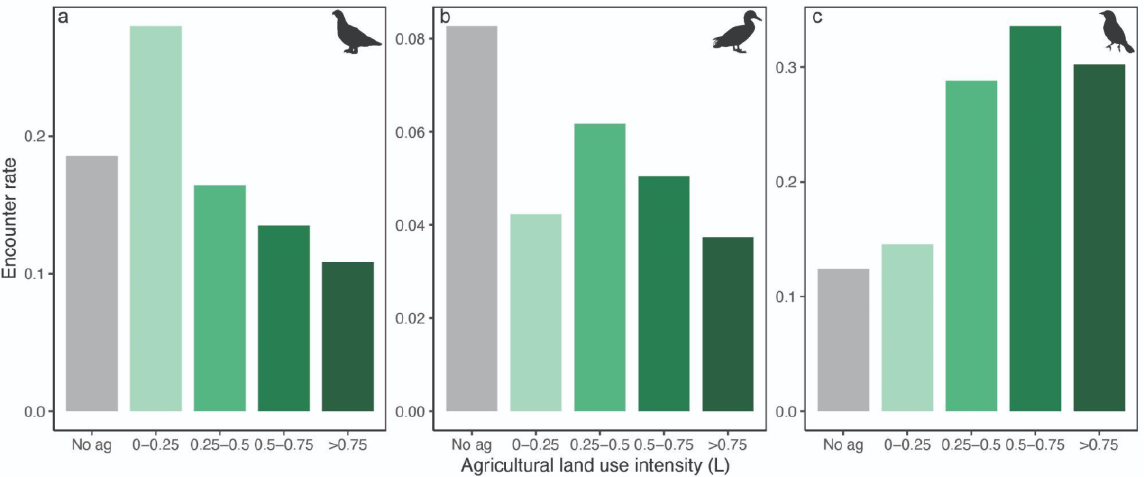
Figure 2. Median encounter rates for ( a ) Greater Sage-Grouse, ( b ) American Black Duck, and ( c ) Bobolink within bins of progressively increasing agricultural land use intensity ( L ). Median values are based on predictions from random forest models at thousands of random locations within each species’ geographic range (see text for